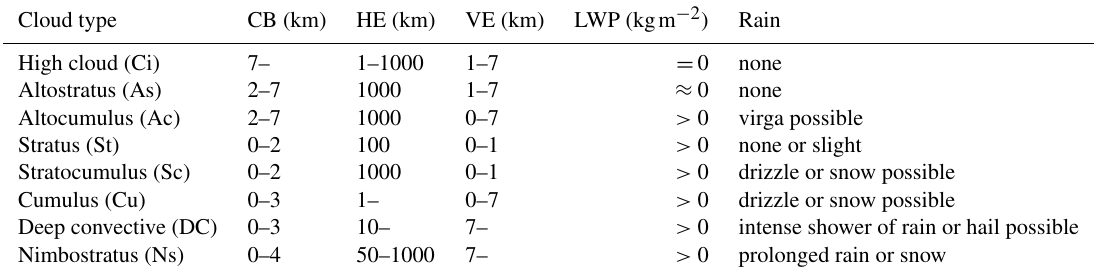
Table 1. Cloud types identified by the 2BCL4 cloud classification algorithm and some of the properties upon which the algorithm is based. Abbreviations: cloud base (CB), horizontal extent (HE), vertical extent (VE), liquid water content (LWP). Adapted from Table 3 in Wang et al. (2012).